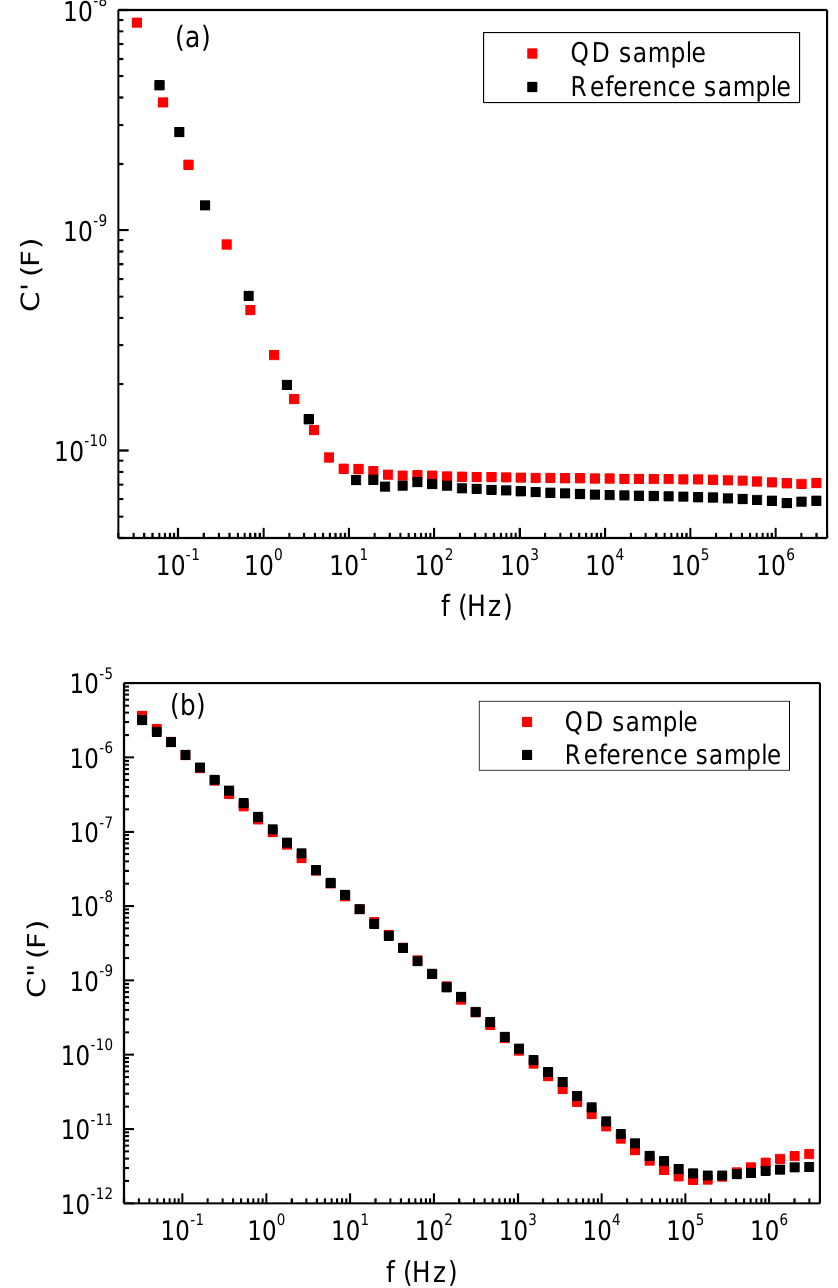
Figure 3. Double-logarithmic plots of real ( a ) and imaginary ( b ) parts of capacitance vs. frequency taken at room temperatures for the quantum dot and reference samples.